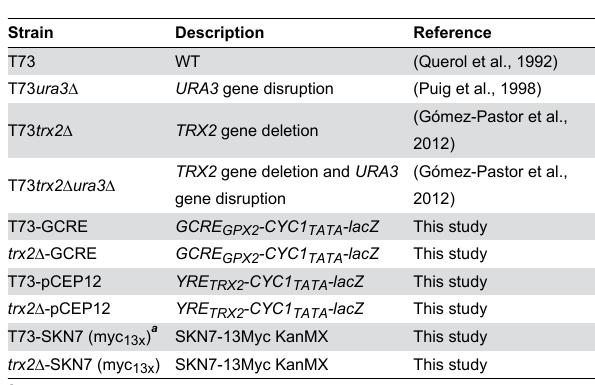
Table 2. Strains used in this